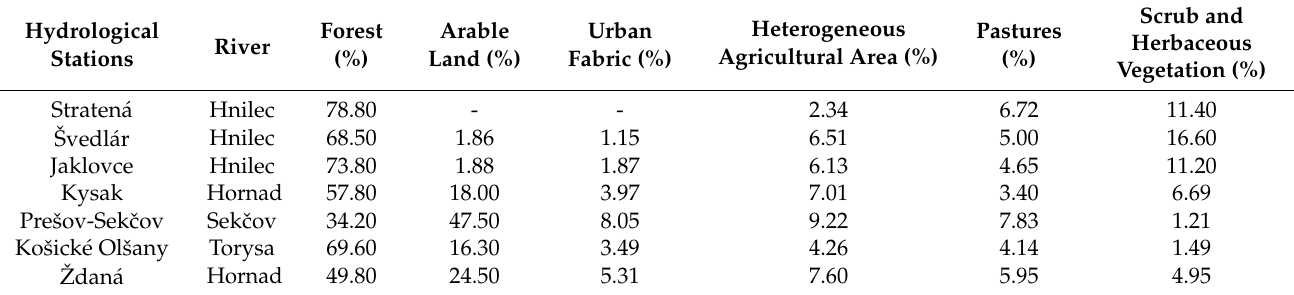
Table 2. Land use in catchments according to CORINE Land Cover (CLC)